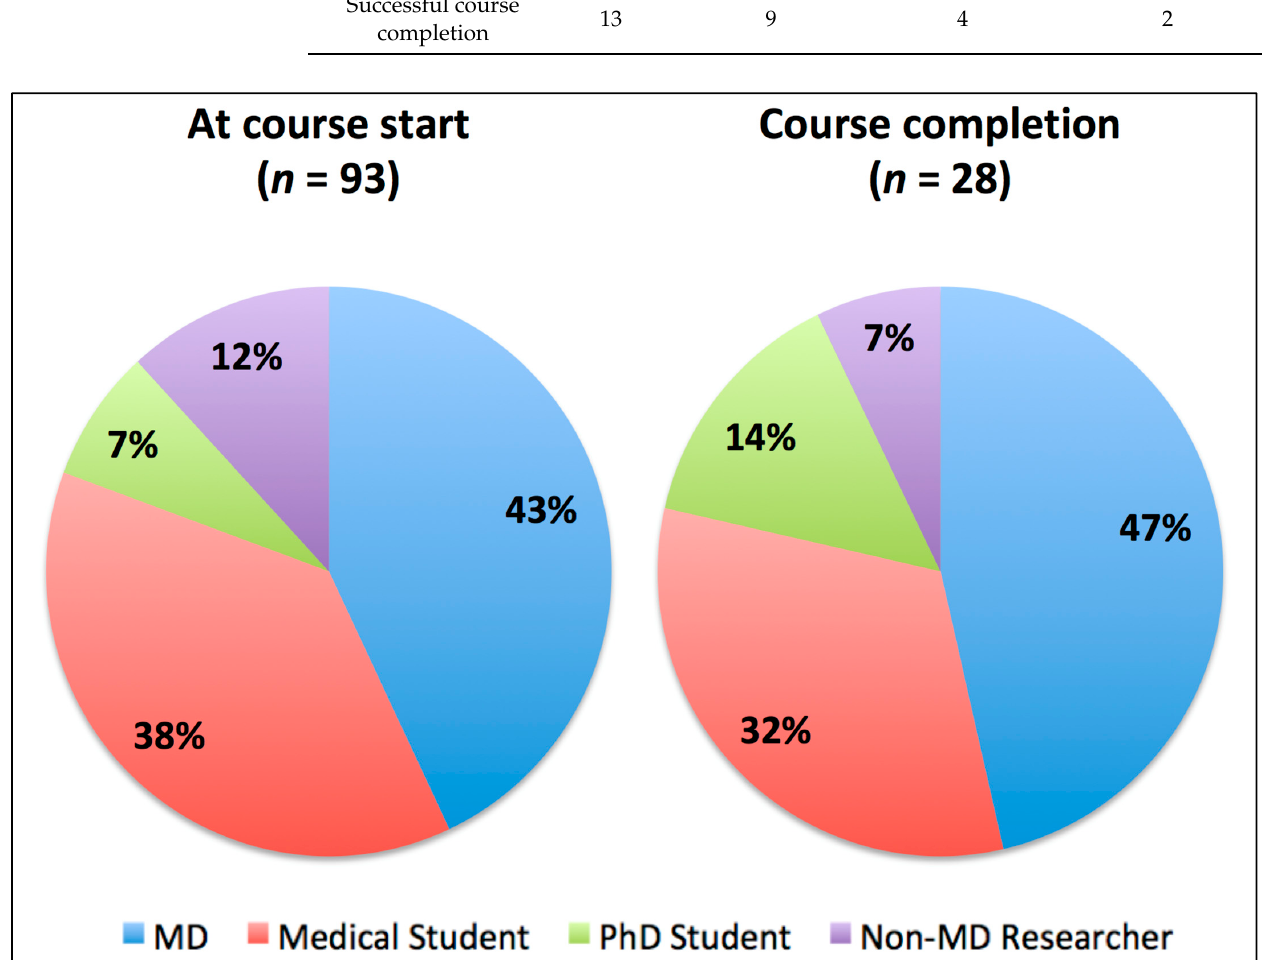
Figure 1. Pie chart diagrams showing the percentages of professional groups at course start ( left ) and after successful course completion ( right ).